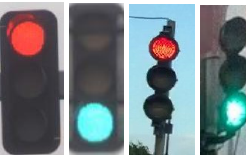
Figure 4. From left to right: the red and green traffic light samples used in training, red and